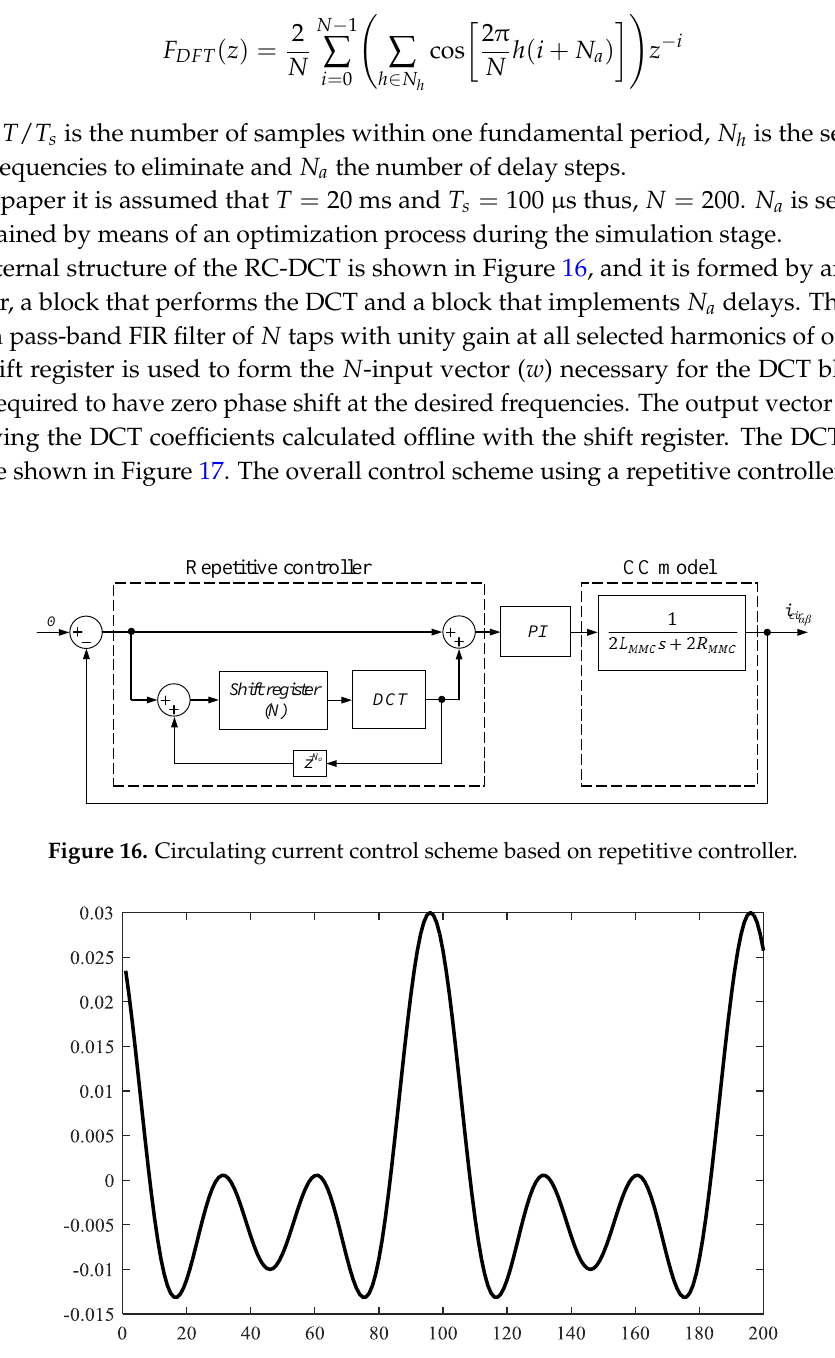
Figure 17. Discrete cosine transform (DCT) coefficients for h = 2, h = 4, h = 6.